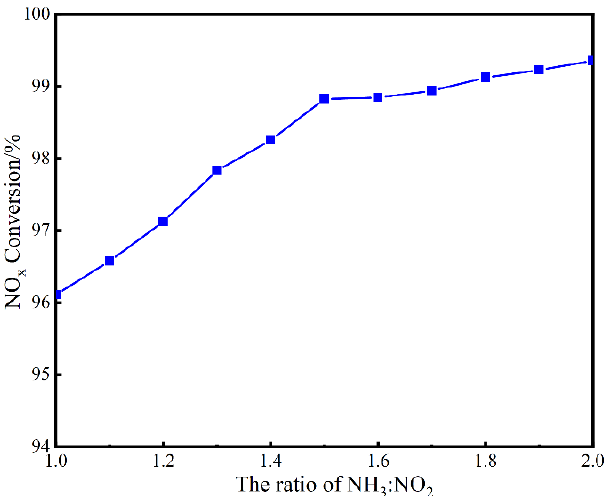
Figure 3. The relationship between the de-NO x efficiency of V 1.6 Mo 2.5 W 0.5 /TiO 2 and the ratio of NH 3 :NO 2 at 220 °C.